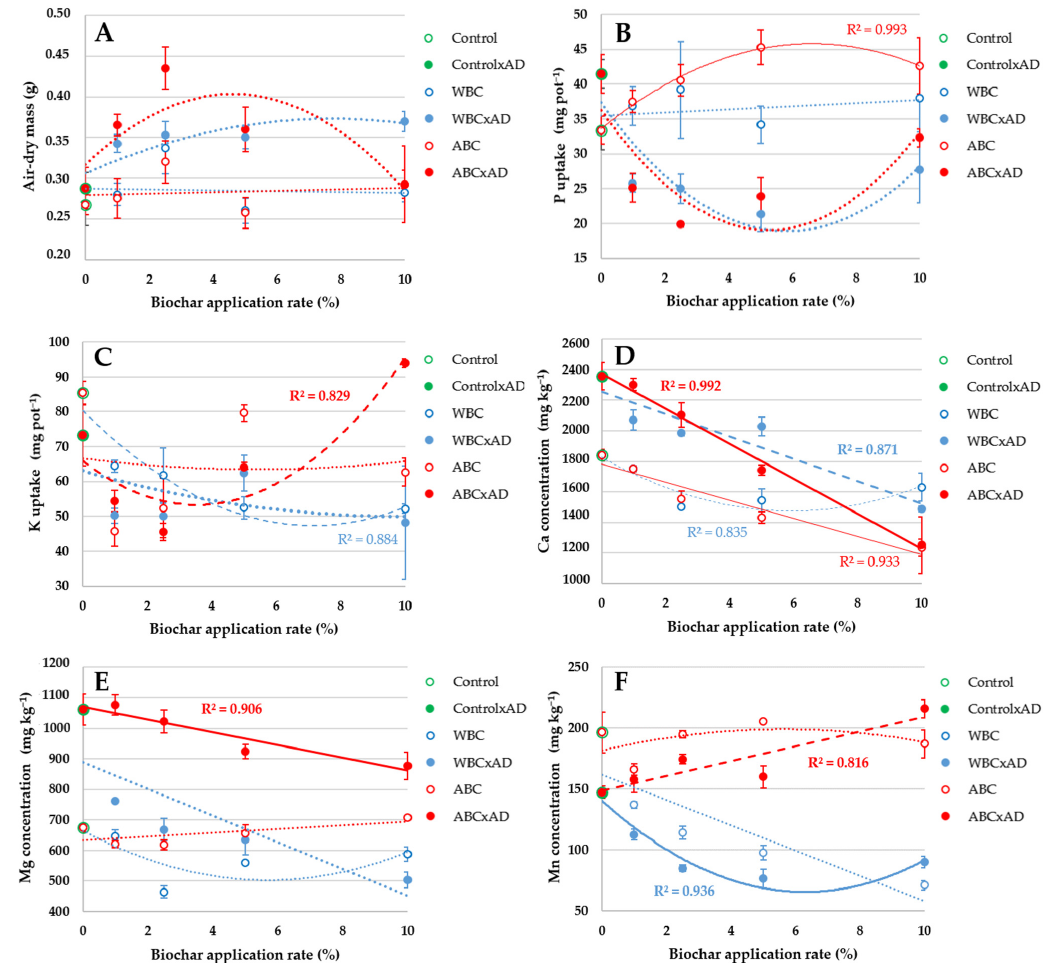
Figure 3. Effects of different biochars (ABC: animal bone biochar; WBC: wood chip biochar) and combined biochar–digestate (ABCxAD: animal bone biochar + anaerobic digestate; WBCxAD: wood